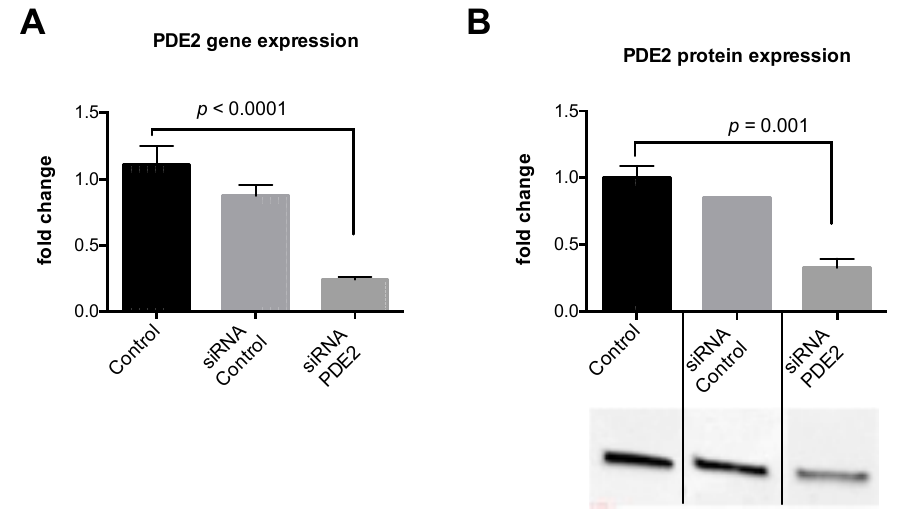
Figure 5. Effect of PDE2 knockdown on PDE2 gene and protein expression. HepG2 cells were transfected with siRNA against PDE2 for 48 hours. ( A ) Gene expression of PDE2 and ( B ) protein expression were measured to confirm the silencing. Bar graphs of densitometry measurements and representative blots are shown ( n = 3).